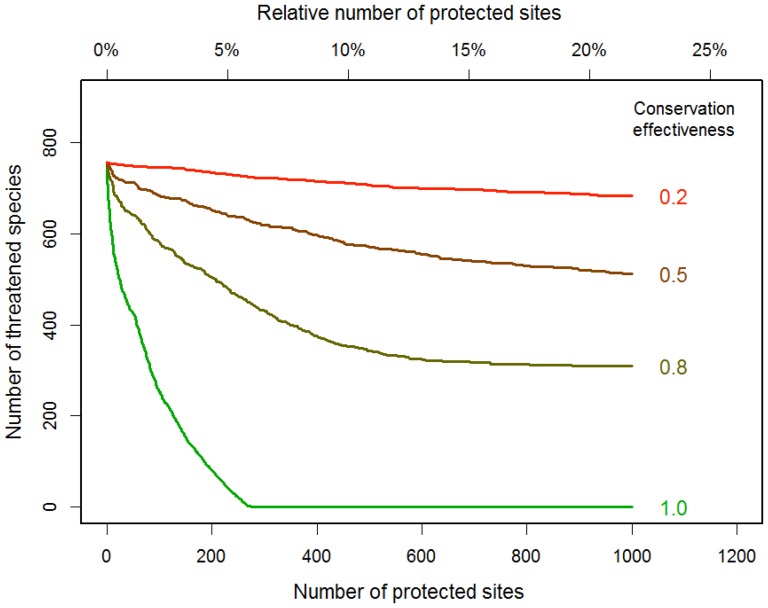
Relationships between number of protected cells and number of species remaining as threatened (probability of extinction in the next 100 years ≥10%).Cells are selected to maximize the reduction of extinction risk (see text for details).